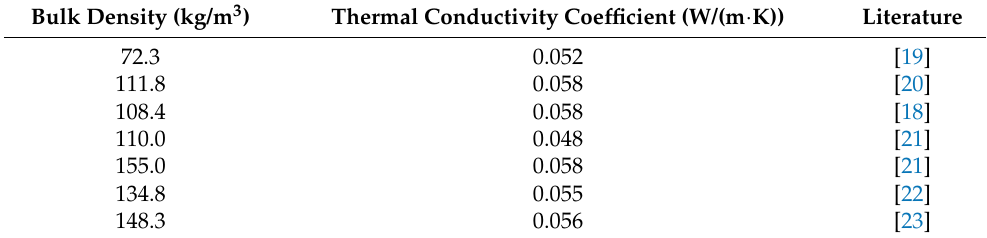
Table 2. Thermal conductivity of hemp shives, a literature review.